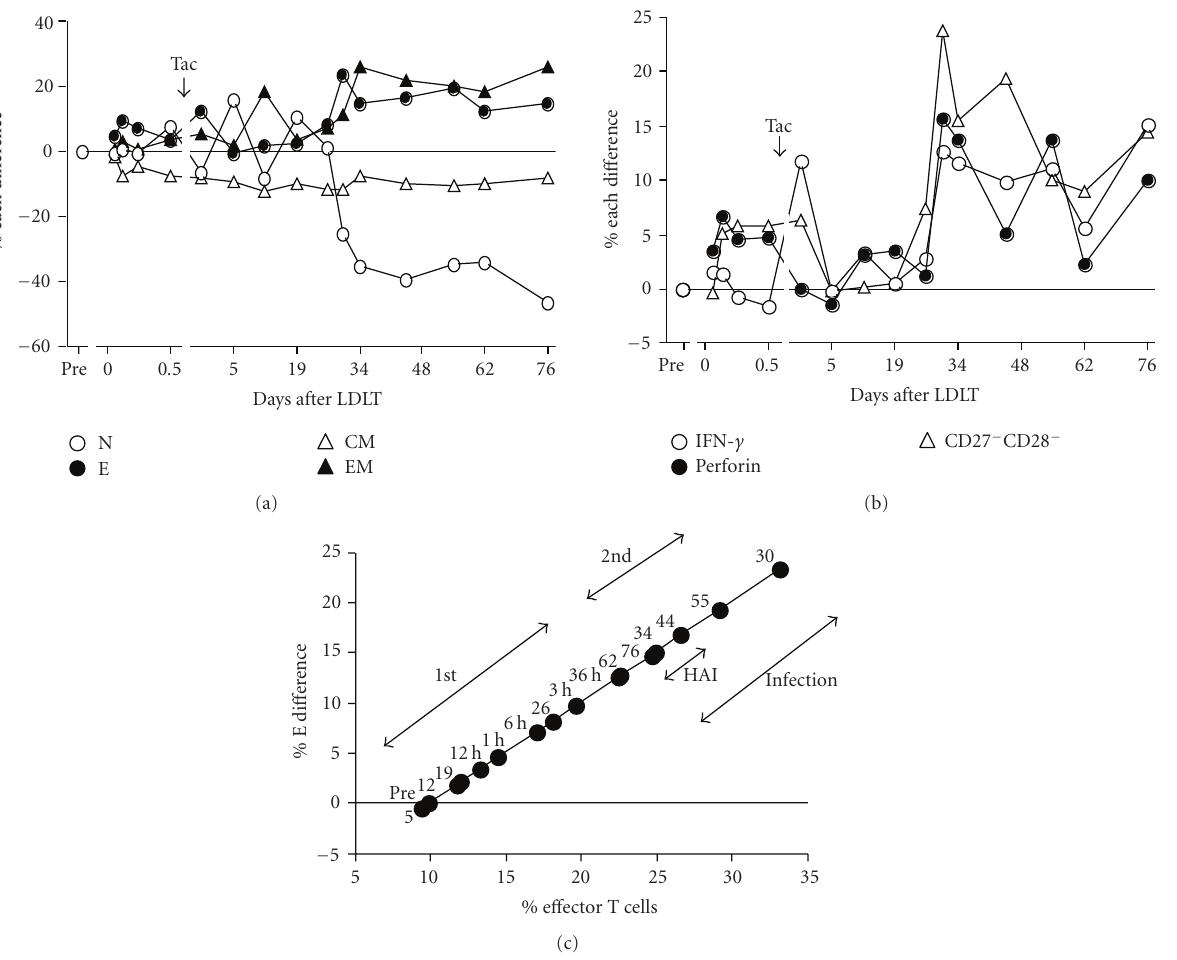
Figure 5: Changes in % di ff erence in CD8 + naive, CM, EM, and e ff ector T cells, as well as IFN- γ , perforin, and CD27 − CD28 − subsets after LDLT in same recipient shown in Figure 4. Low (c), scatter plot between % E di ff erence and % e ff ector T cell proportion. 1st phase is the period before Tac administration. 2nd phase is the period after Tac administration. Pre, pre-LDLT; Tac, tacrolimus; the number above black circles in (c) figure, postoperative days. (a) N, naive T cells; E, e ff ector T cells; CM, central memory T cells; and EM, e ff ector memory T